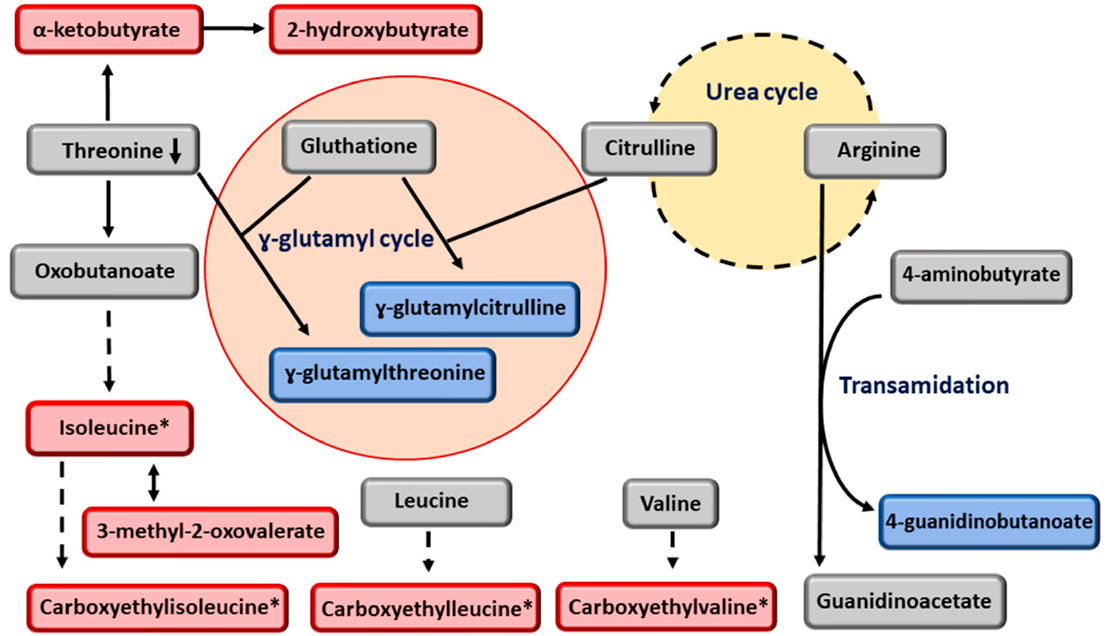
Figure 3 . Novel metabolites associated with GCKR rs780094-T in men with NAFLD. Red color indicates increased and blue color decreased concentration of the metabolites. Grey color indicates that these metabolites were not significantly associated with GCKR rs780094-T. *Metabolites from gut microbiota.